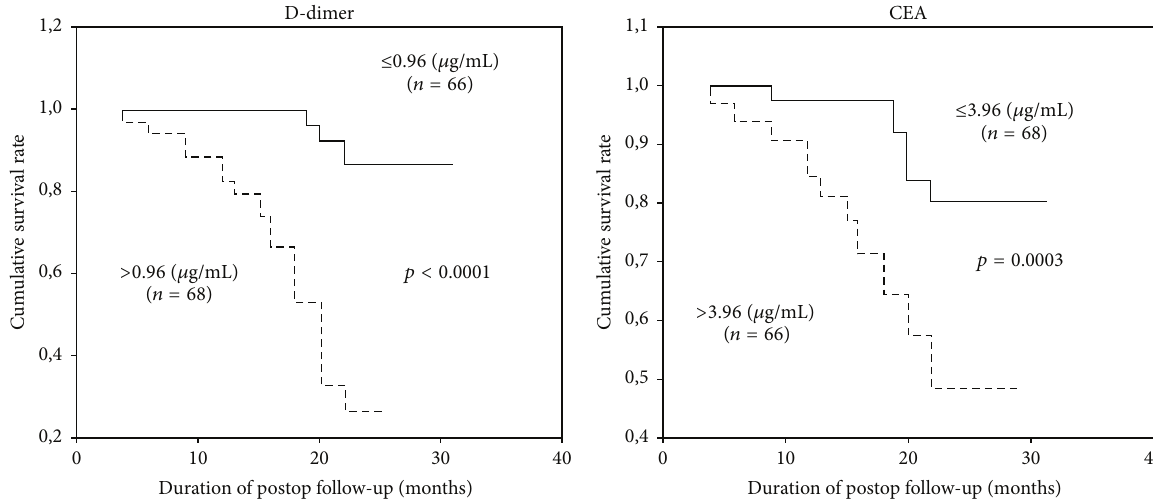
Figure 2: Relationship between the postoperative general survival and preoperative D-dimer and CEA levels.